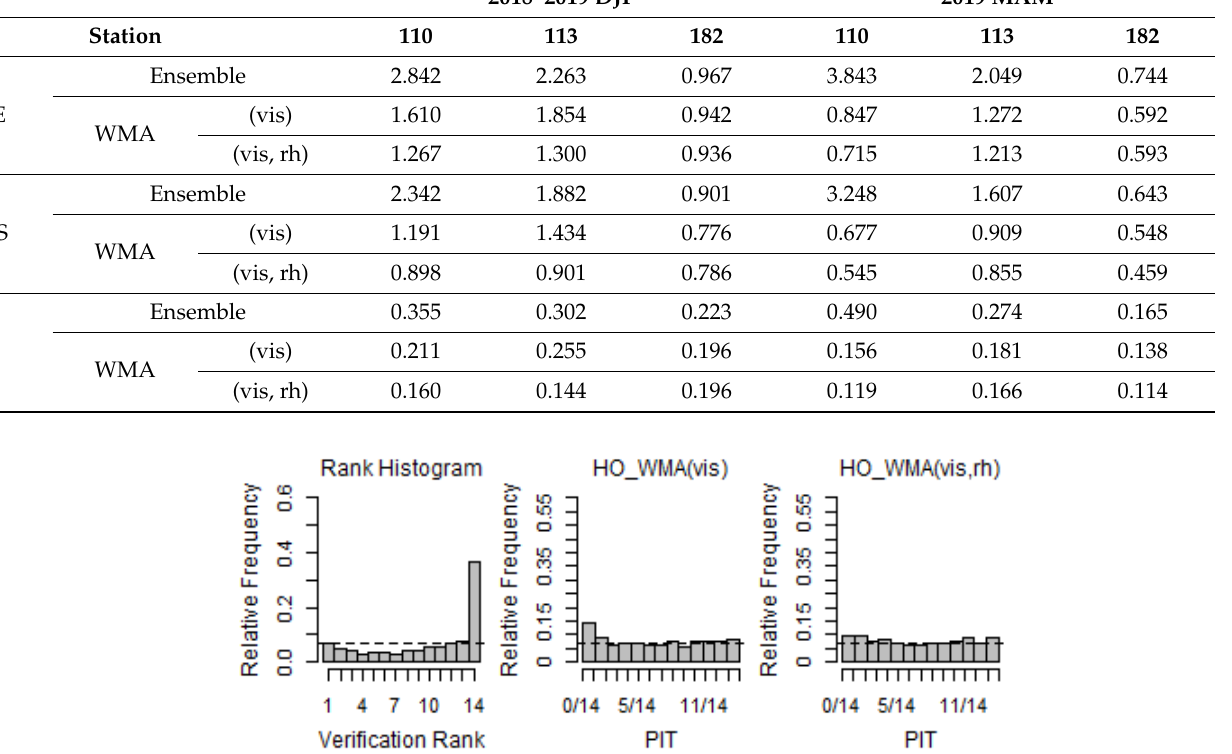
Figure 7. Verification rank histogram of raw ensemble forecasts and PIT histograms of WMA mod- els for Station 110 (2019 MAM). Figure 8. Verification rank histogram of raw ensemble forecasts and PIT histograms of WMA mod- els for Station 113 (2019 MAM). Figure 9. Verification rank histogram of raw ensemble forecasts and PIT histograms of WMA mod- els for Station 182 (2019 MAM).